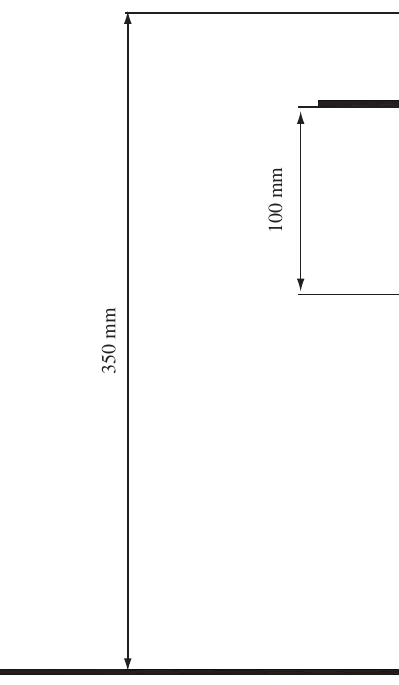
Figure 1. Rod in the modified slump apparatus. Top plate in detail 13 .